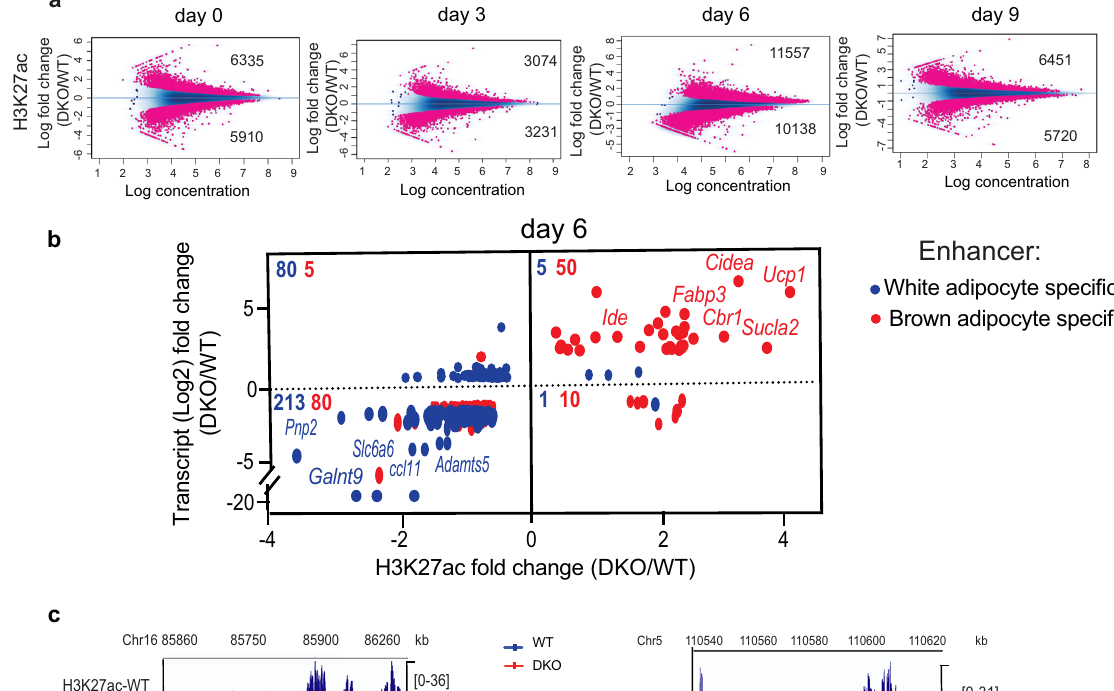
replicates. b Correlation plot of H3K27ac with transcript levels at white and brown speci fi c enhancers. The red and blue numbers in the upper left of each quadrant indicate the number of white and brown adipocyte-speci fi c genes. c , d IGV screenshots showing H3K27acand transcriptlevelsatwhite ( c ) and brown-speci fi c enhancers ( d ) at day 6 of preadipocyte